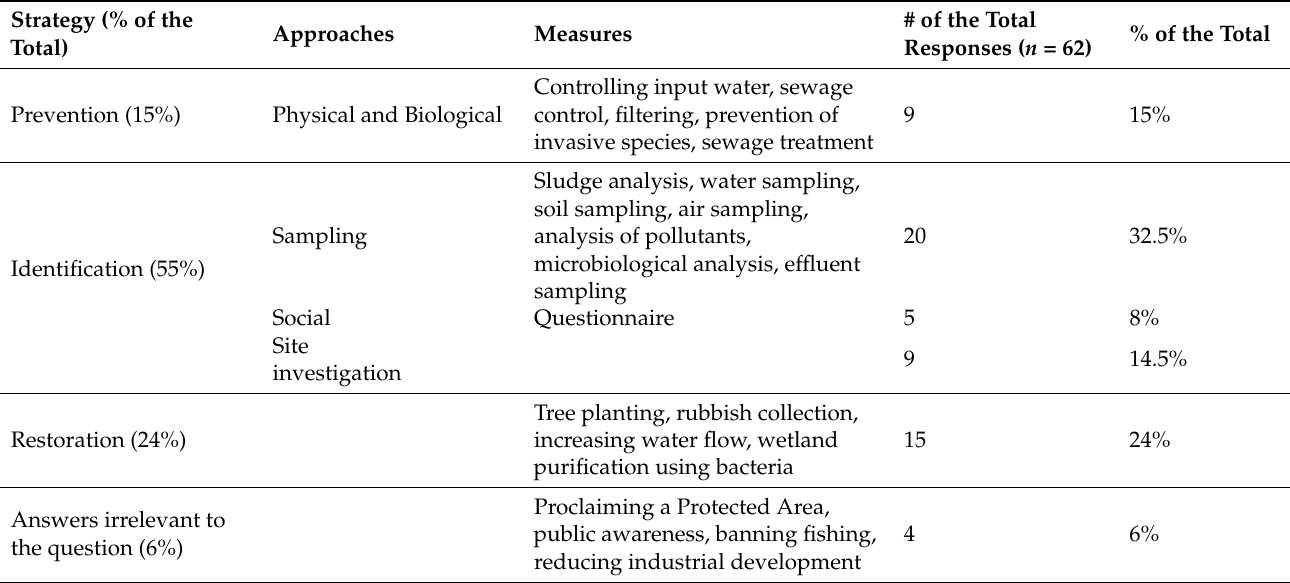
Table 2. Summary of students’ survey on approaches to identify wetland odor.